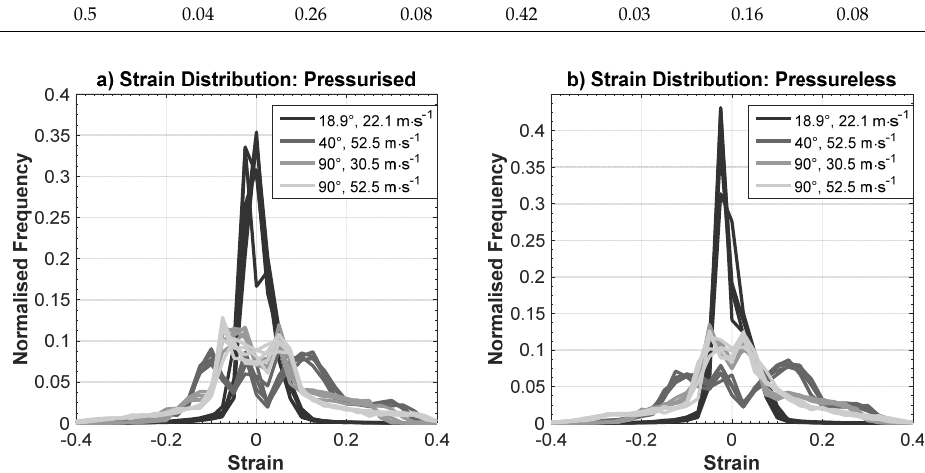
Figure 8. Strain distribution during impact for pressurised ( a ) and pressureless ( b ) ball cores.